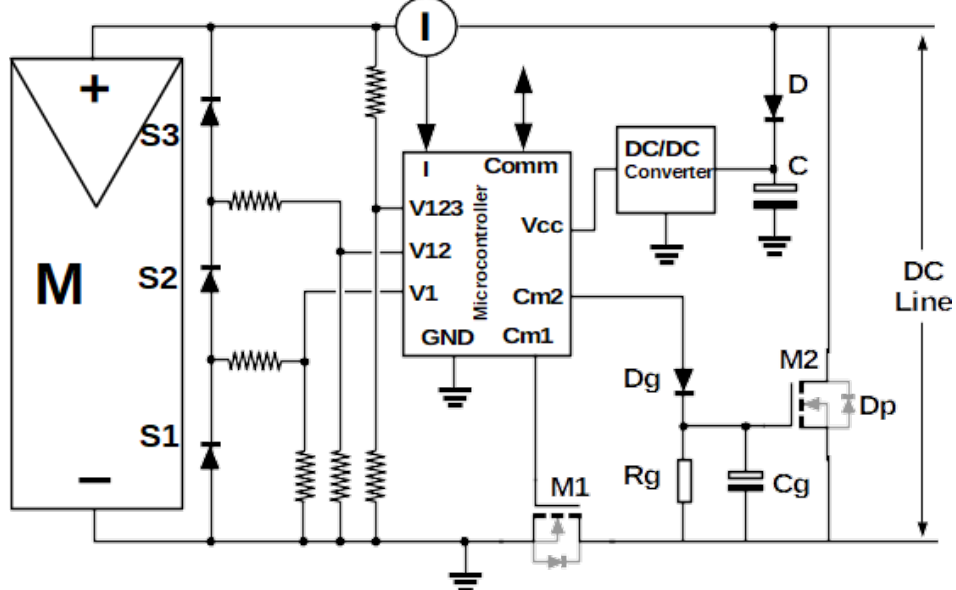
Figure 2. Schematics of the electronic board installed in each module for the distributed strategy.